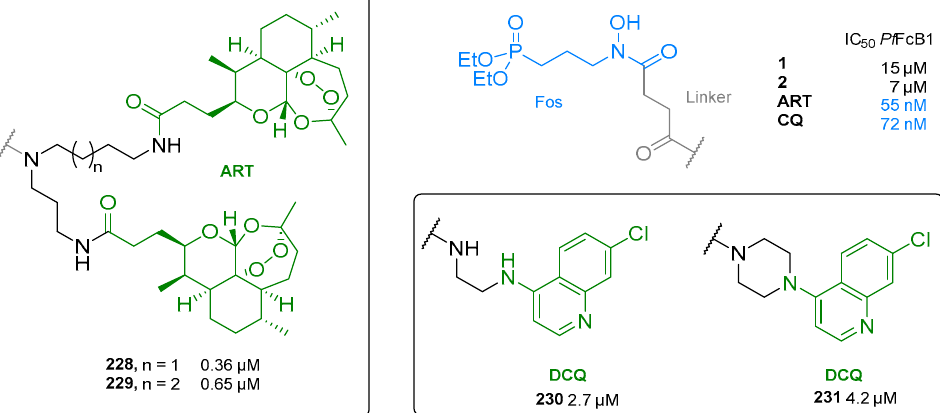
Figure 44. Antiplasmodial activities of artemisinin (ART)-conjugates 228 – 229 and desalkylchloroquin (DCQ) hybrids ( 230 – 231 ) against chloroquine-resistant P. falciparum FcB1 strain with ART and CQ as references. Compared to the diethyl phosphonate ester of fosmidomycin (structure not shown), which was completely inactive towards P. falciparum FcB1, the artemisinin conjugates 228 and 229 exhibited potent activity with IC 50 values of 0.36 and 0.65 µM, respectively.